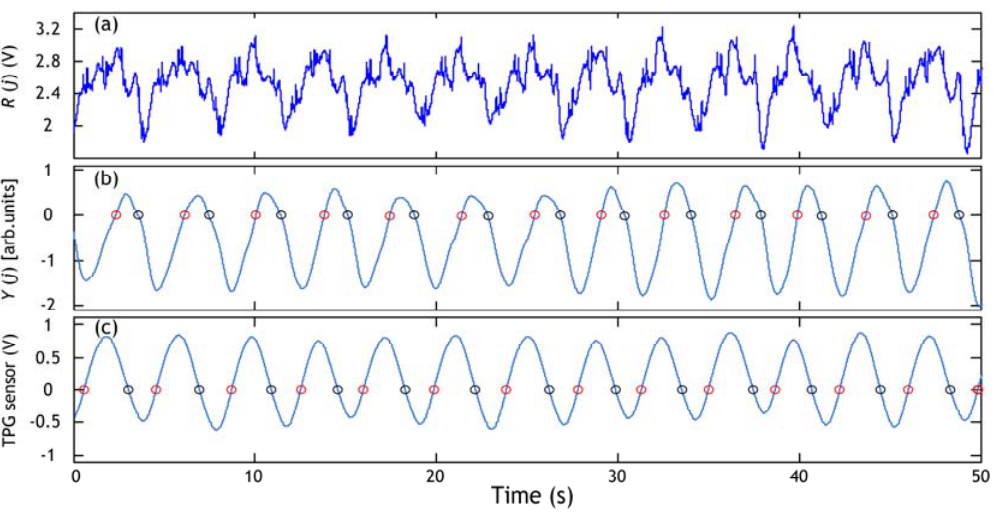
Figure 6. Extraction of respiratory cycle information. (a) PVDF sensor output. (b) Respiration signal derived from PVDF output. (c) Respiration signal obtained with TPG sensor. Circles represent respiratory cycle information estimated during inhalation time (positive slope) or respiratory cycle estimated during expiration time (negative slope).